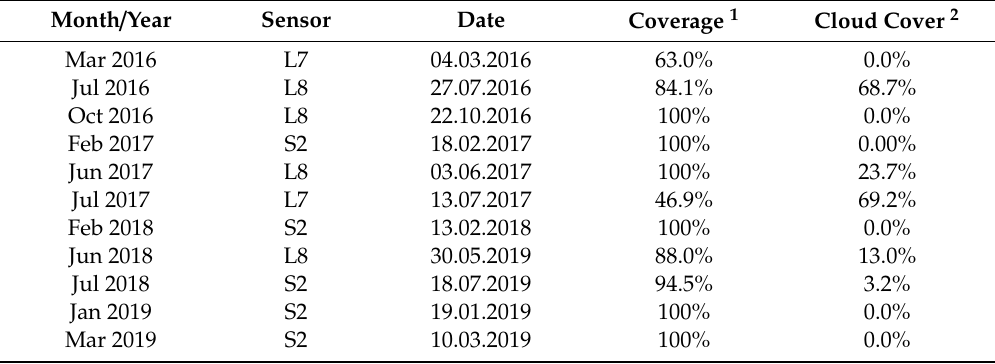
Table 2. Optical data used in this study. L7 = Landsat ETM + , L8 = Landsat OLI, S2 = Sentinel-2. Month /